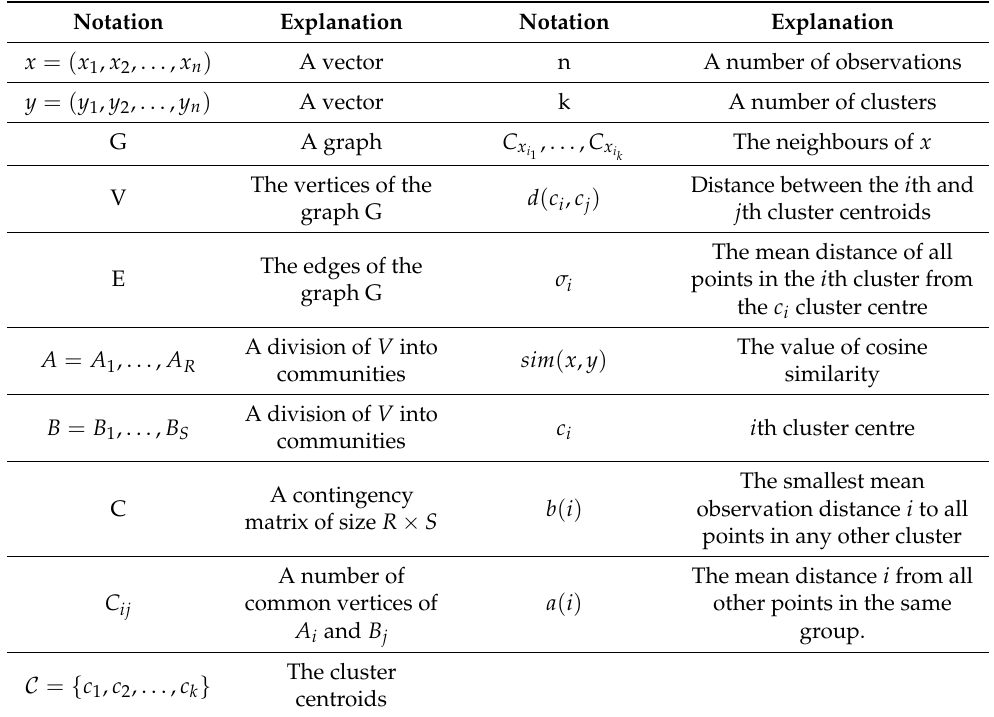
Table 1. Summary of main notations in the